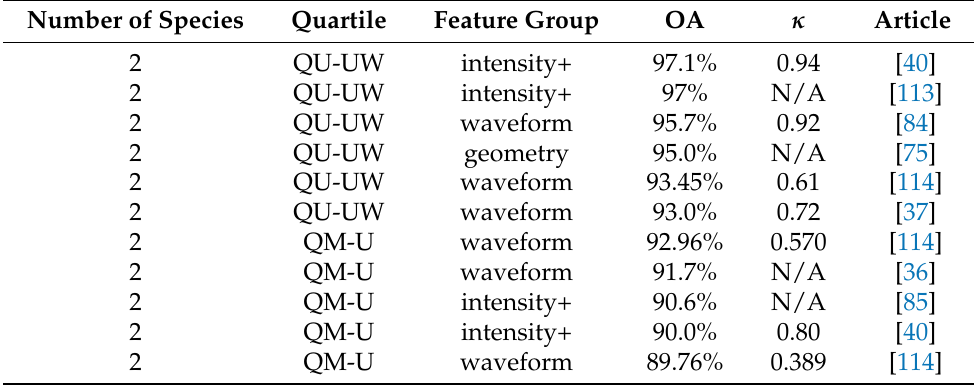
Table A4. List of studies with overall accuracy greater than the median overall accuracy of all studies for each number of species with information about the quartiles; QM-U—the range from the median to upper quartile, QU-UW—the range from the upper quartile to the upper whisker; list sorted by species number and